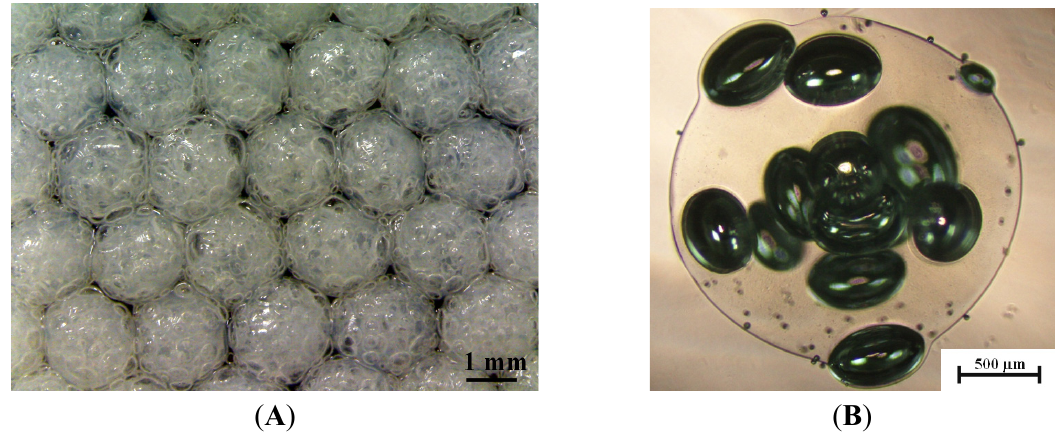
Figure 1. Photo images of porous alginate particles. ( A ) Uniform microparticle distribution with an average diameter of 2.25 ± 0.11 mm and ( B ) Close-up view of a single microparticle with gas bubbles inside.